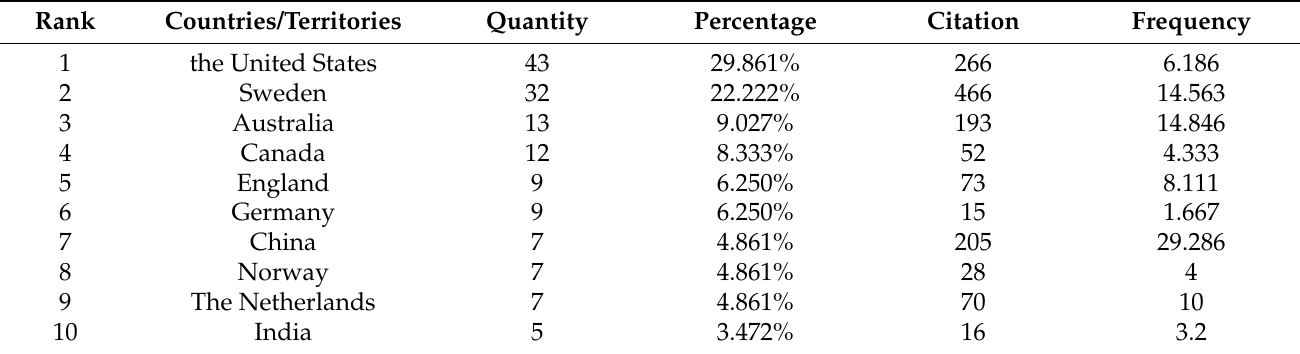
Table 1. Top 10 productive countries,